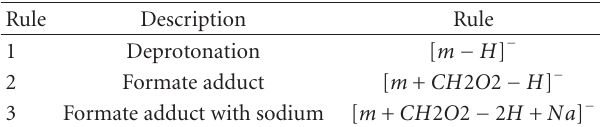
Table 2: List of adduct rules for correction of data measured in negative ionization mode.